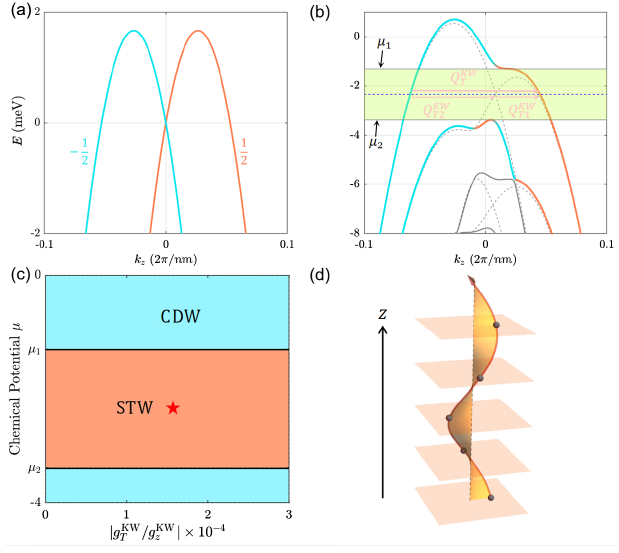
FIG. 2. Kramers-Weyl semimetals. (a) Band structure near Γ point in k axis. (b) Lowest Landau bands when magnetic fields z 10 T and rotation symmetry breaking term δ B are both z ¼ T μ − μ 2 . 4 meV applied, where the latter leads to a gap 2 δ 1 2 ¼ T ¼ between n ¼ 1 and 2 Landau bands. The color shades in red and 1 = 2 , and blue denote proportions of wave functions with s z ¼ (cid:2) they are mixed due to C 2 breaking. (c) The phase diagram of z ground state has two regimes, where the area in burnt orange is self-twisting wave (STW) when Fermi level lies within the gap [area in olive of (b)] while other blue regimes are CDW phase. The red star marks the parameters used in Fig. 3. Here we set coupling constants g ¼ 0 . 5 g − . (d) Schematics of charge center þ (black dots) distribution in self-twisting wave